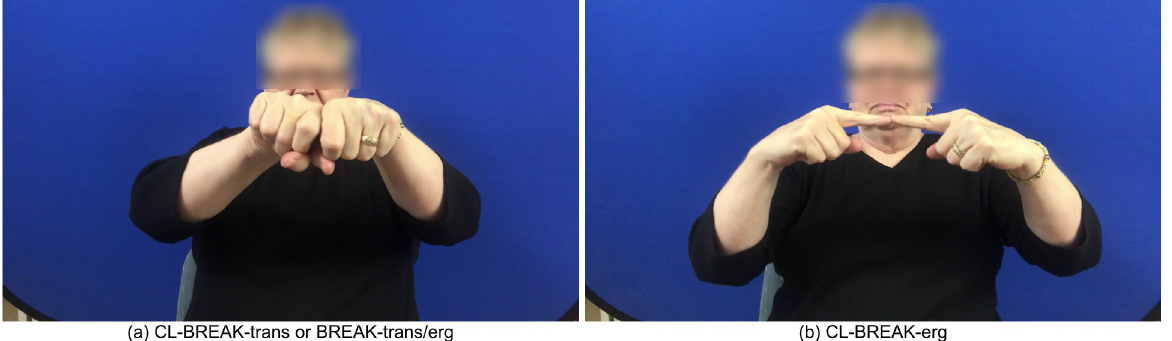
Fig 4. Transitive-unergative distinction in classifier constructions. Three signs meaning break in ASL. (a) and (b) are classifier constructions, within ASL’s classifier system, and are used in transitive (I broke the stick) and unergative (The stick broke) contexts, respectively. A lexical sign, BREAK is historically related to (a) and shares most relevant visual properties. As a lexical sign, BREAK may be used in both transitive and unergative contexts.